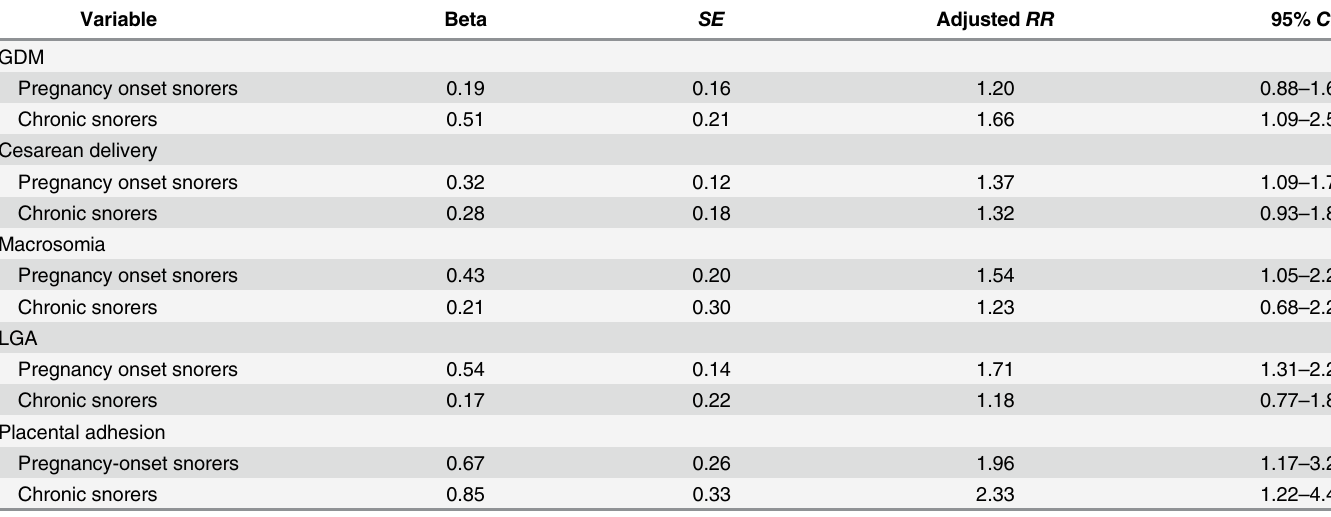
Table 3. Regression analyses of maternal and newborn outcomes against snoring and other